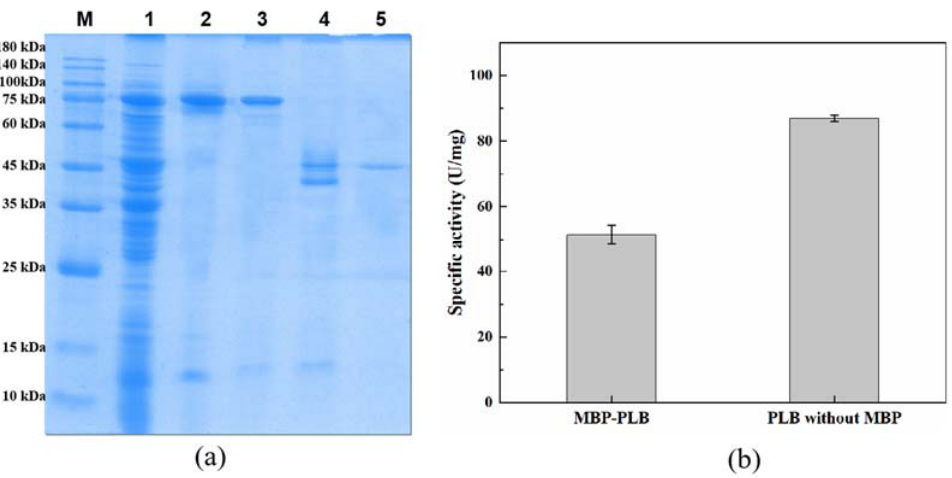
Figure 2. Effect of maltose-binding protein (MBP) as fusion partner on recombinant PLB. ( a ) SDS-PAGE analysis and ( b ) enzyme activity of PLB. Lane M: protein molecular weight marker; lane 1: supernatant of E. coli BL21(DE3)/pMal-c5x-PLB; lane 2: precipitation of E. coli BL21(DE3)/pMal-c5x-PLB; lane 3: eluted protein; lane 4: mixture with factor Xa; lane 5: